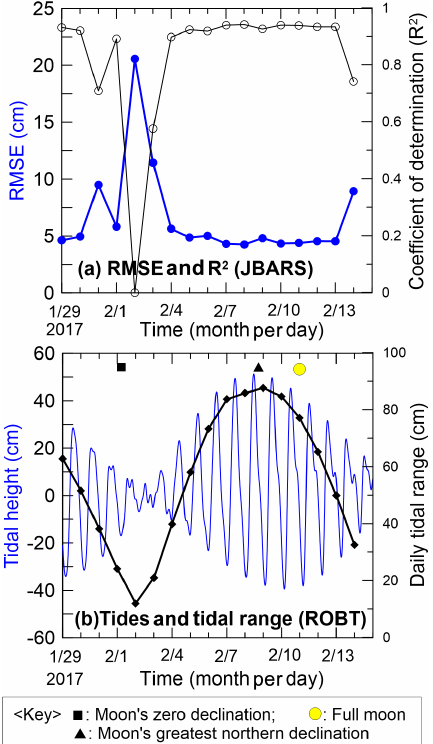
Figure 6. (a) Time series (29 January to 14 February 2017) of RM- SEs (thick blue line with ) and coefficients of determination ( R 2 , thin black line with ) between JBARS 10min interval sea level observations and the CTSM + TCC prediction data sets, generated for this site using harmonic analysis results from the JBARS daily (25h) sea level data slices and concurrent daily (25h) 2017 tidal prediction data slices and harmonic analysis results from ROBT station’s year-long (2017) tidal predictions. (b) Time series of pre- dicted 2017 tidal heights (thin blue line) and daily tidal ranges (thick black line with ) for ROBT, based on harmonic analysis of this sta- tion’s 2013 5min interval sea level record, plus an indication of the Moon’s phase and